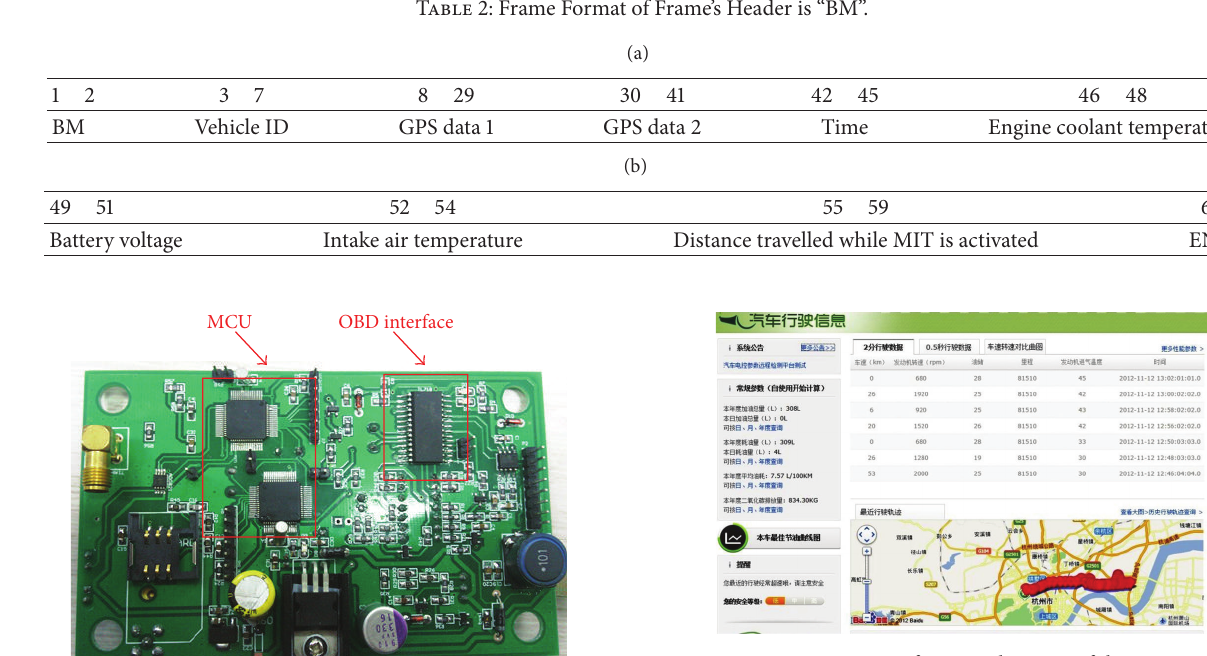
Table 2: Frame Format of Frame’s Header is “BM”.